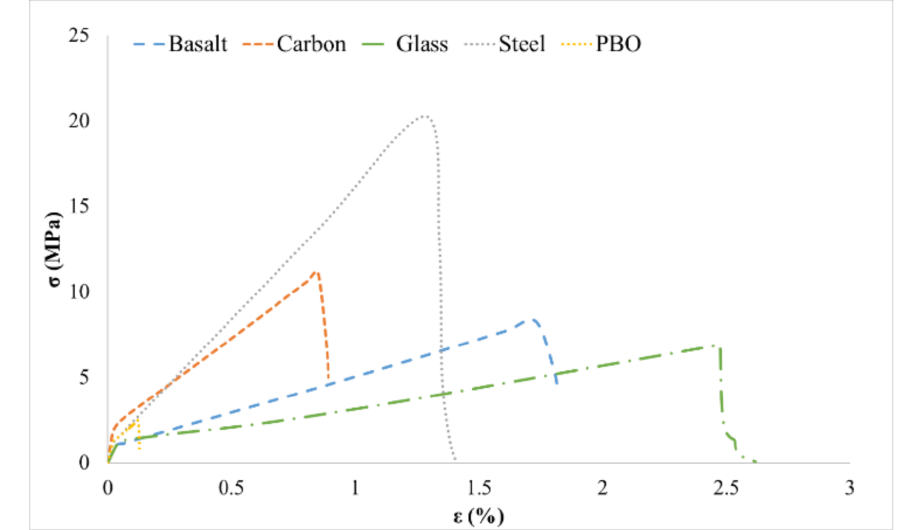
Figure 6. FRCM stress–strain diagrams (numerical model